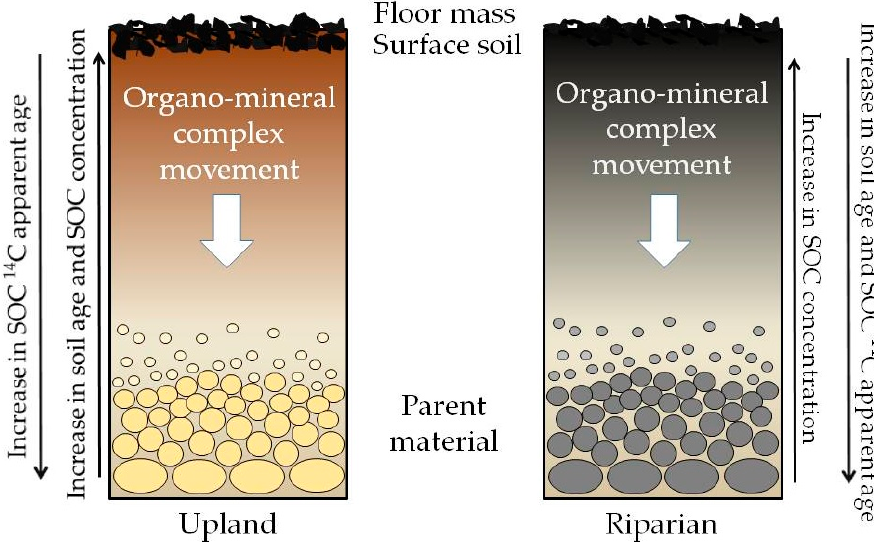
Figure 7. Schematic diagram showing the downward movement of organo-mineral complex along soil profiles and changes in soil organic carbon (SOC) 14 C apparent age, soil age and SOC concentration with soil depth in the upland and riparian soils.